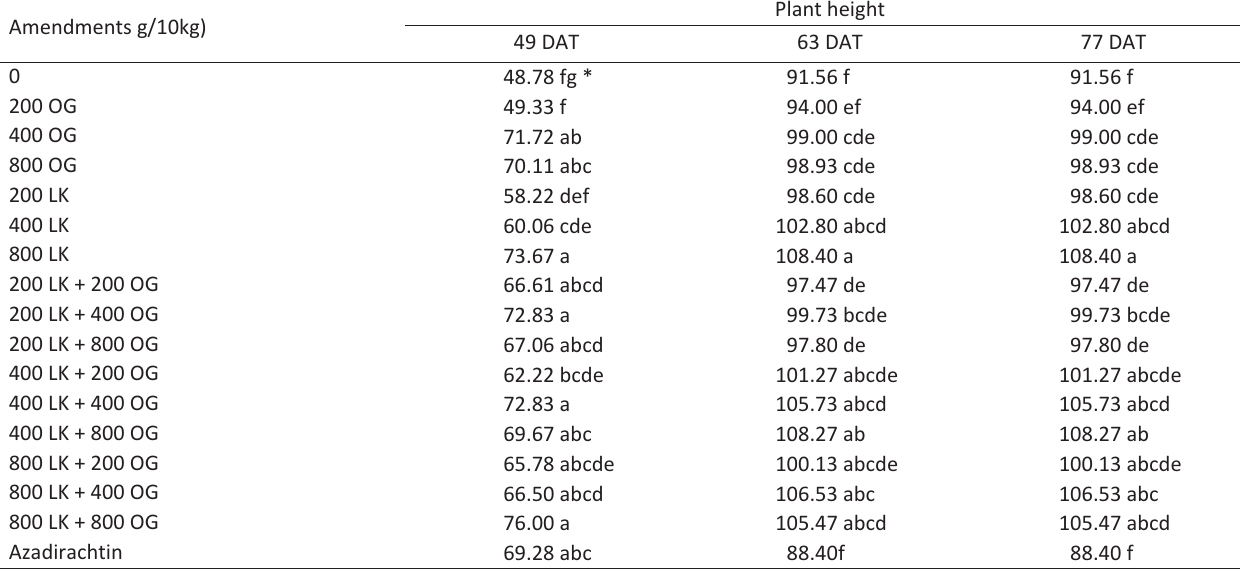
Table 5 ­ Effect of fresh plant biomass from Lippia kituensis Vatke and Ocimum gratissimum L. on tomato plant